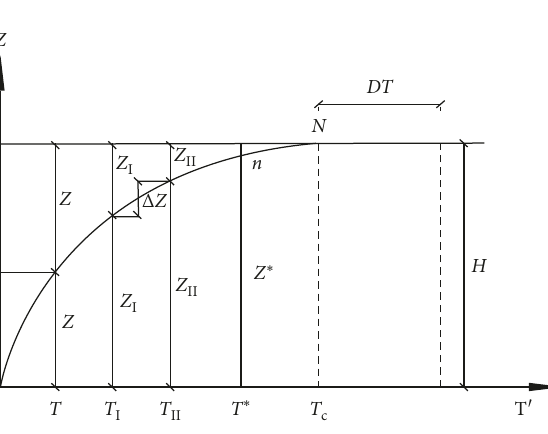
Figure 4: Variation of fill height with